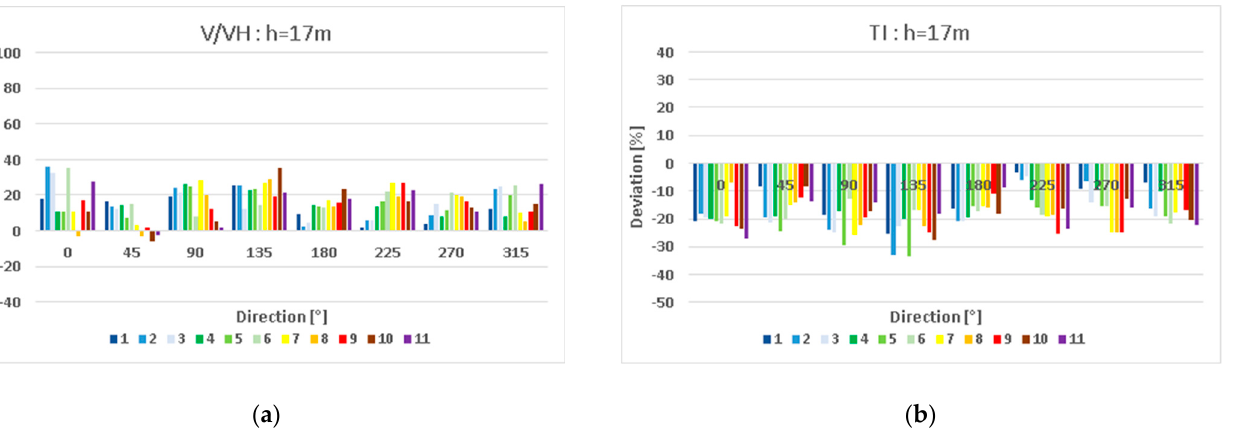
Figure 27. Mean absolute deviations of the wind ( a ) and turbulence intensity ( b ) per direction for the 11 probe validation points at height h = 17 m with OpenFOAM.